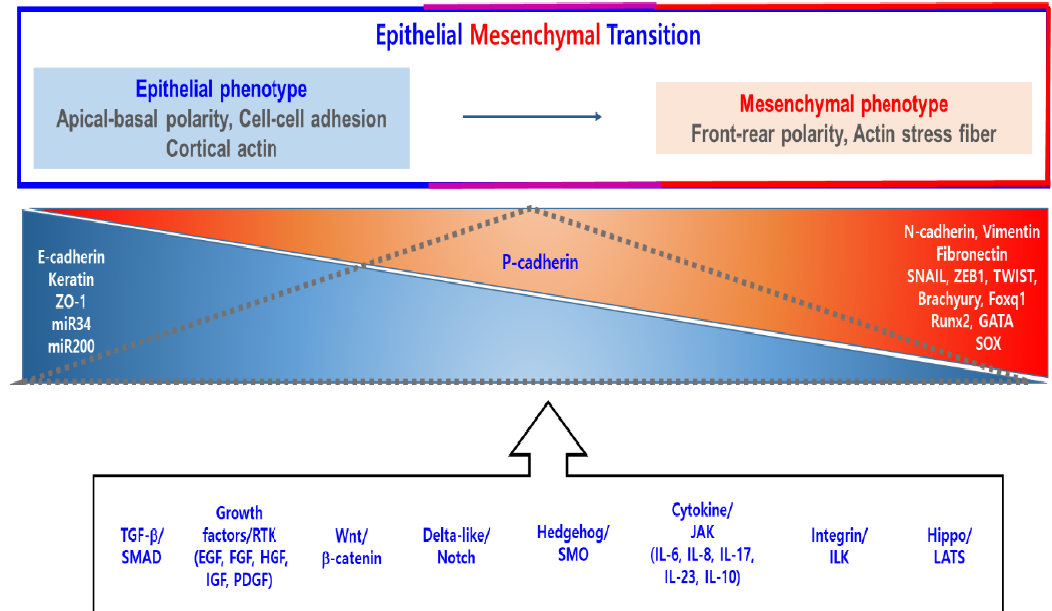
Figure 1. Epithelial – mesenchymal transition (EMT).E-cadherin: Epithelial cadherin; EGF: Epidermal Growth Factor; FGF: Fibroblast Growth Factor; GATA: GATA Binding Protein; HGF: Hepatocyte Growth Factor; IGF: Insulin Like Growth Factor; ILK: Integrin Linked Kinase; JAK: Janus Kinase; LATS: Large Tumor Suppressor Kinase; miR34: microRNA 34; miR200: microRNA 200; N-cadherin: Neural cadherin; P-cadherin: Placental cadherin; PDGF: Platelet Derived Growth Factor; Runx2: RUNX Family Transcription Factor 2; SMAD: Sma- And Mad-Related Protein; SMO: Smoothened, Frizzled Class Receptor; SOX: SRY-Box Transcription Factor; TGF- β : Transforming Growth Factor Beta; Wnt: Wingless-Type MMTV Integration Site Family; ZEB1: Zinc Finger E-Box Binding Homeobox 1; ZO-1: Zona Occludens 1.